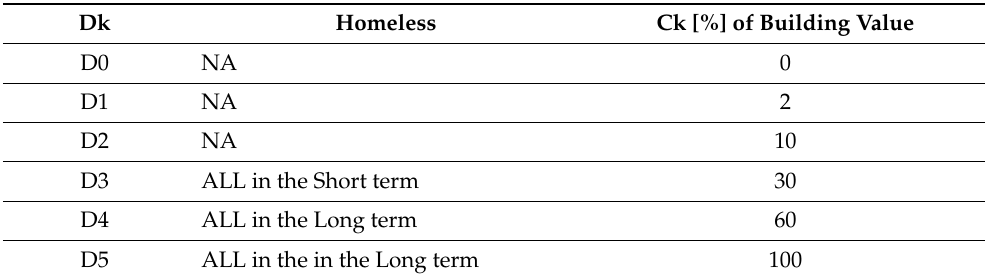
Table 11. Assumed correlation between physical damage level Dk, and cost level Ck defined of [%] of building value required for repair or rebuilding interventions.